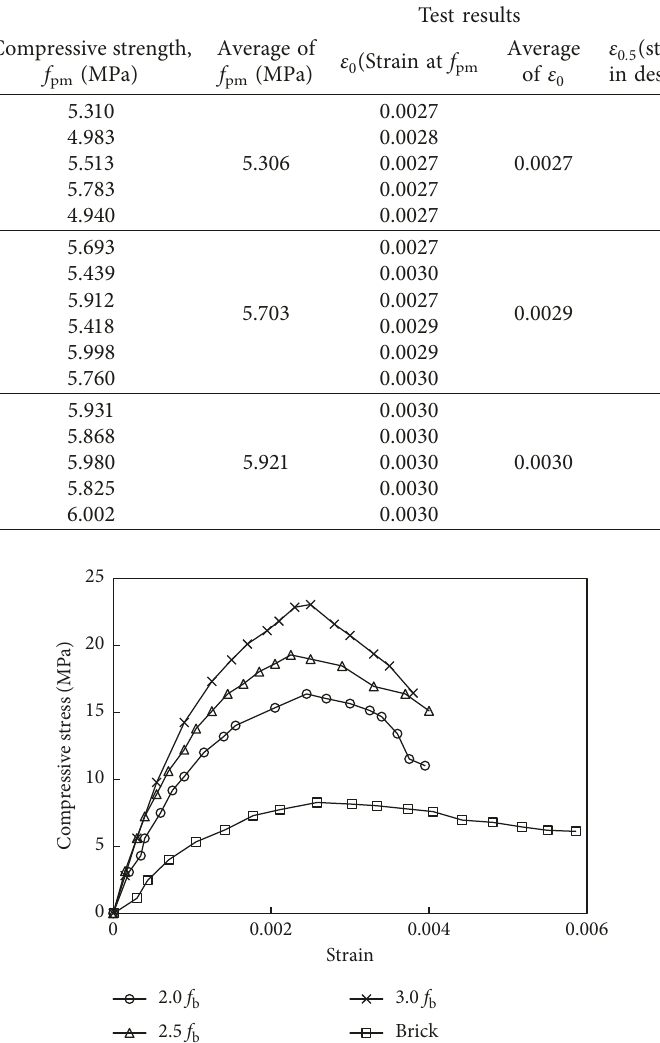
Figure 2: Compressive stress-strain curves measured in the mortars and the brick